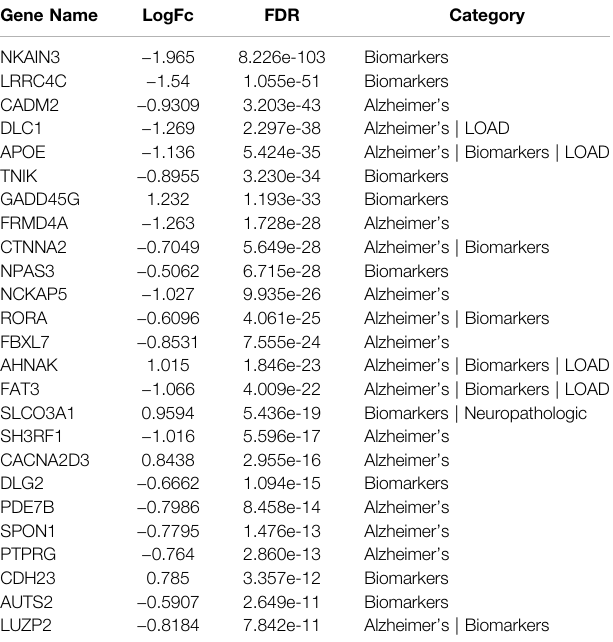
TABLE 6 | Top 25 differentially expressed GWAS genes in astrocytes from entorhinal cortex in AD brain based on analysis using the web tool available at